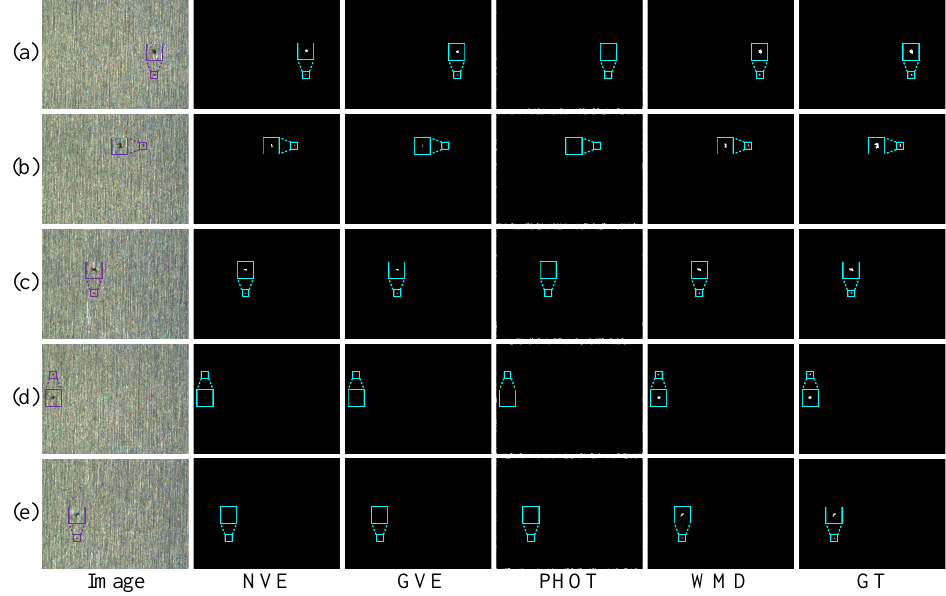
Figure 10. Visual comparisons of four methods on ( a – e ) five randomly selected single-defect images. The detection result of the proposed WMD method is quite close to ground truth (GT), whereas the other competing methods are unable to either identify the defect location or completely separate the defect from the